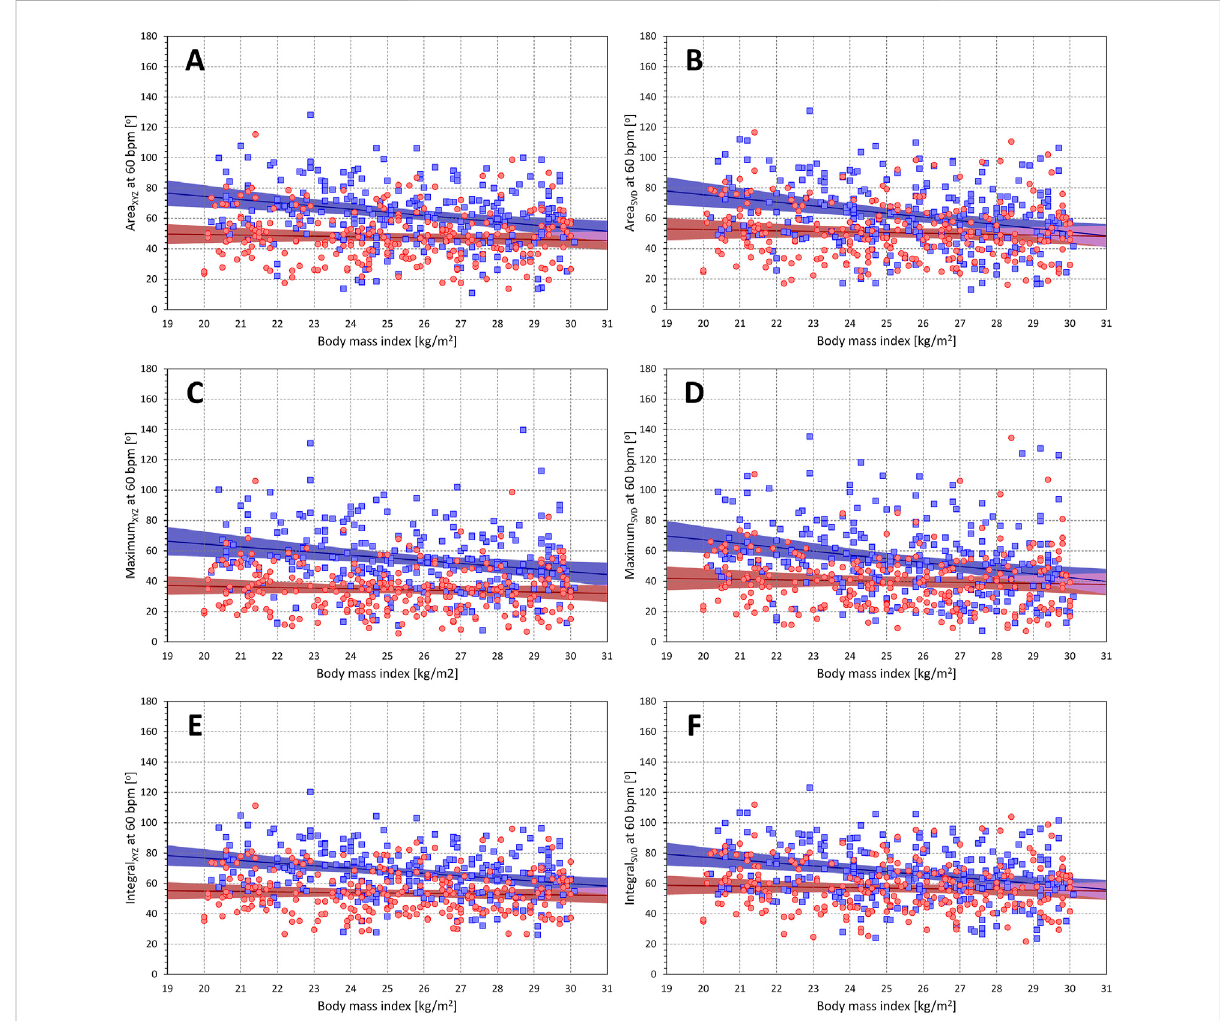
FIGURE 12 Relationship of QRS-T angle (projections to heart rate of 60 bpm) to body mass index. The different panels of the fi gure show scatter diagrams between body mass index and subject-speci fi c projections of different QRS-T angle expressions to the heart rate of 60 bpm. Panels (A – F) show QRS-T angle data of Area XYZ , Area SVD , Maximum XYZ , Maximum SVD , Integral XYZ , and Integral SVD , respectively. In each panel, the red circles and blue squares show thedata of female and male subjects, respectively. The red and blue bold lines are linear regression of QRS-Tangle to body mass index in female and male sub-populations, respectively. The light red and light blue areas are the 95% con fi dence bands of the sex-speci fi c regressions, the light violet areas are the overlaps between the regression con fi dence bands of both